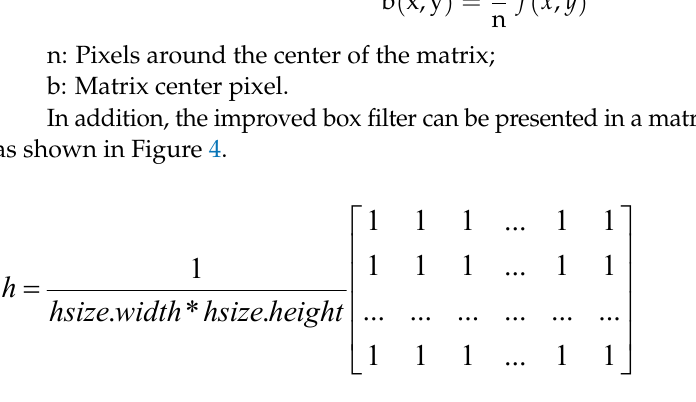
Figure 4. Box filtering model.